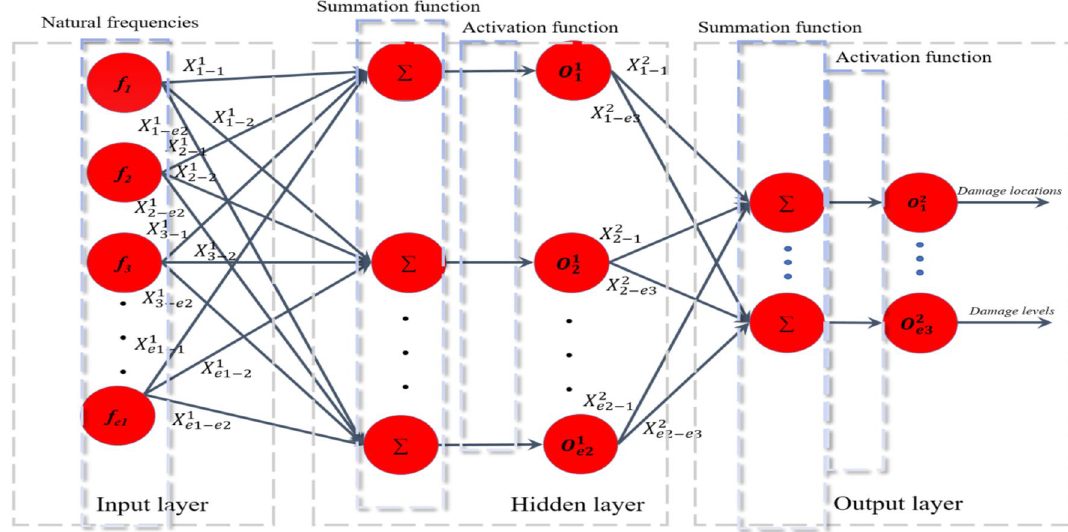
Figure 2. The network